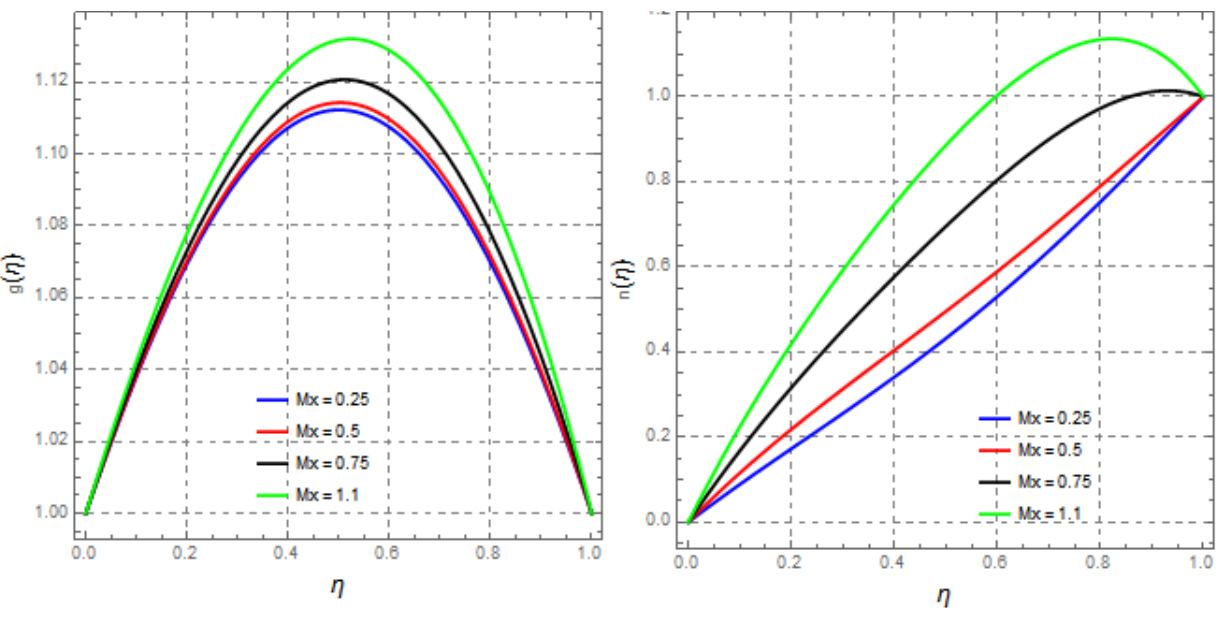
Figure 10. Impact of Magnetic field strength M x on velocity component g and magnetic field component n , Keeping S z = − 0.25, M y = 3, R m = 0.5 and S =